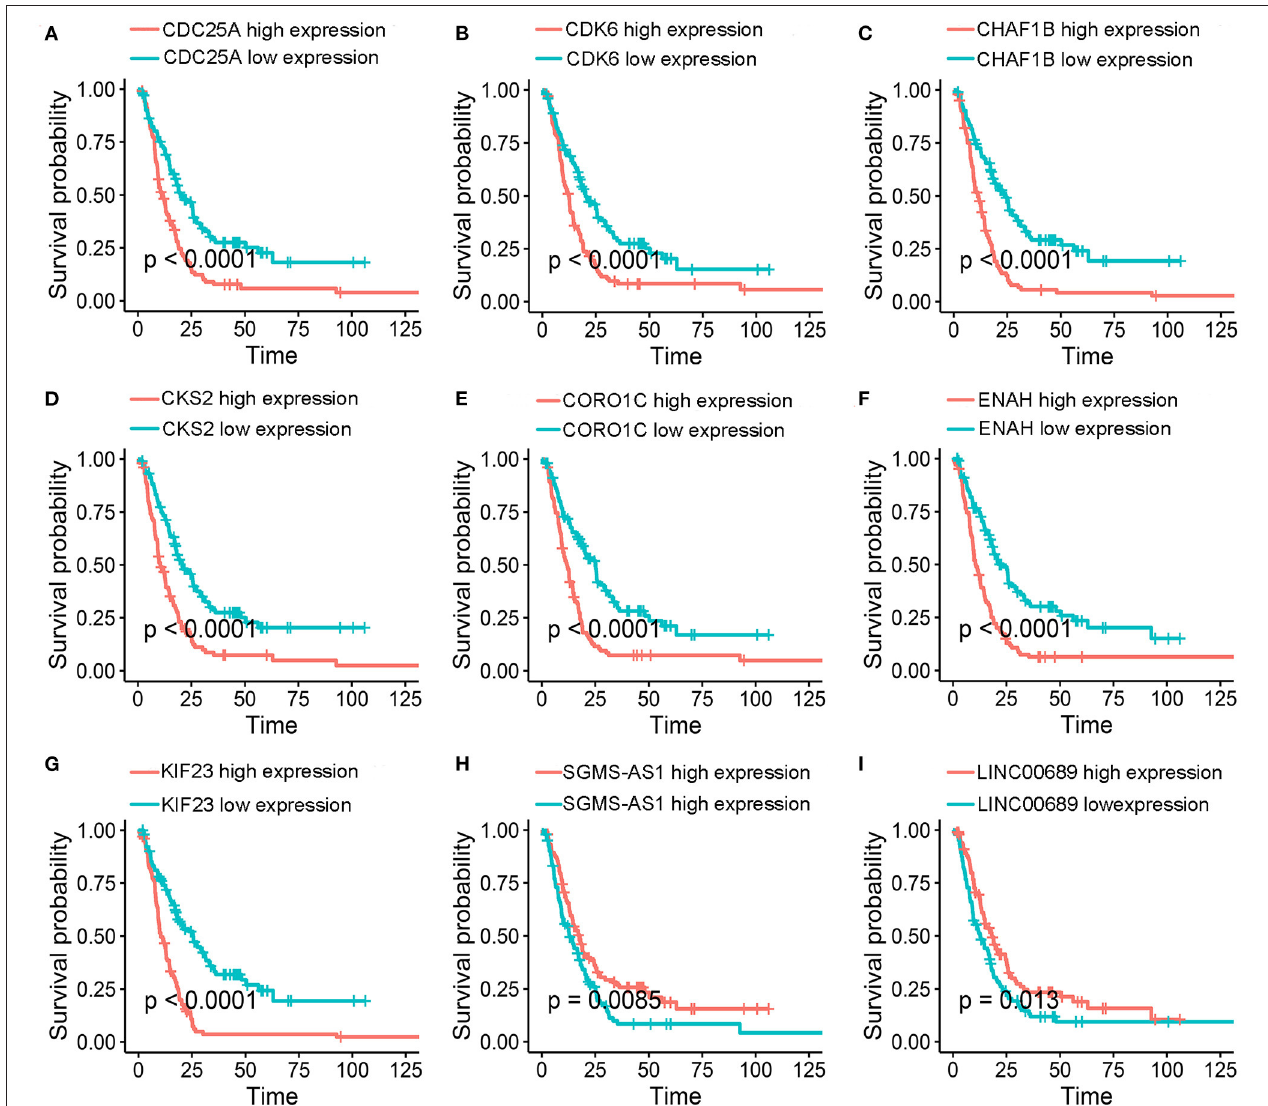
FIGURE 7 | Kaplan–Meier survival analyses. (A-I) Validation of of the nine genes in the model based on the EGA MPM dataset. The statistical significances were determined by the log-rank